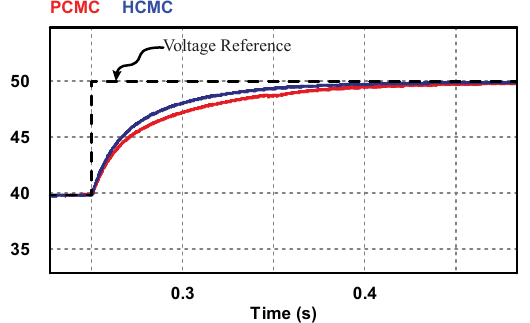
Figure 17. Simulation results of the voltage response of the proposed HCMC and conventional